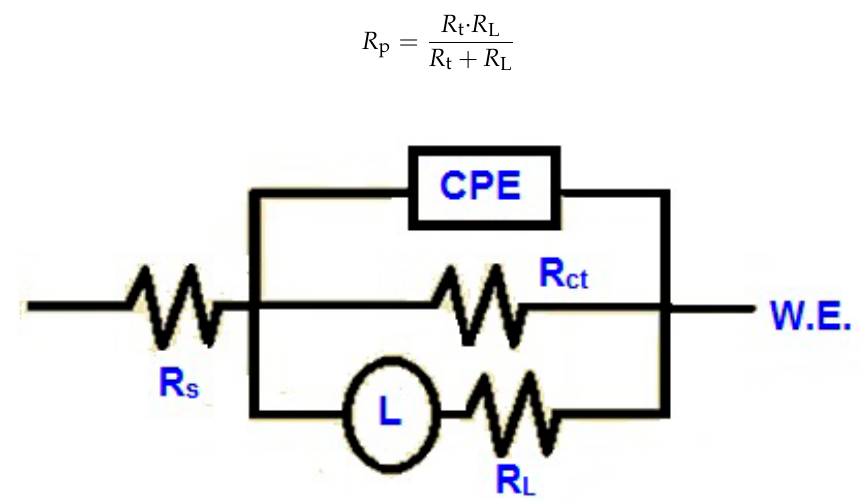
Figure 6. Equivalent electric circuits for quantitative estimation of EIS spectra. Table 3. EIS data for the corrosion of AA 6061 alloy in 1 M HCl in the existence of different concentration of inhibitor at 303 K.